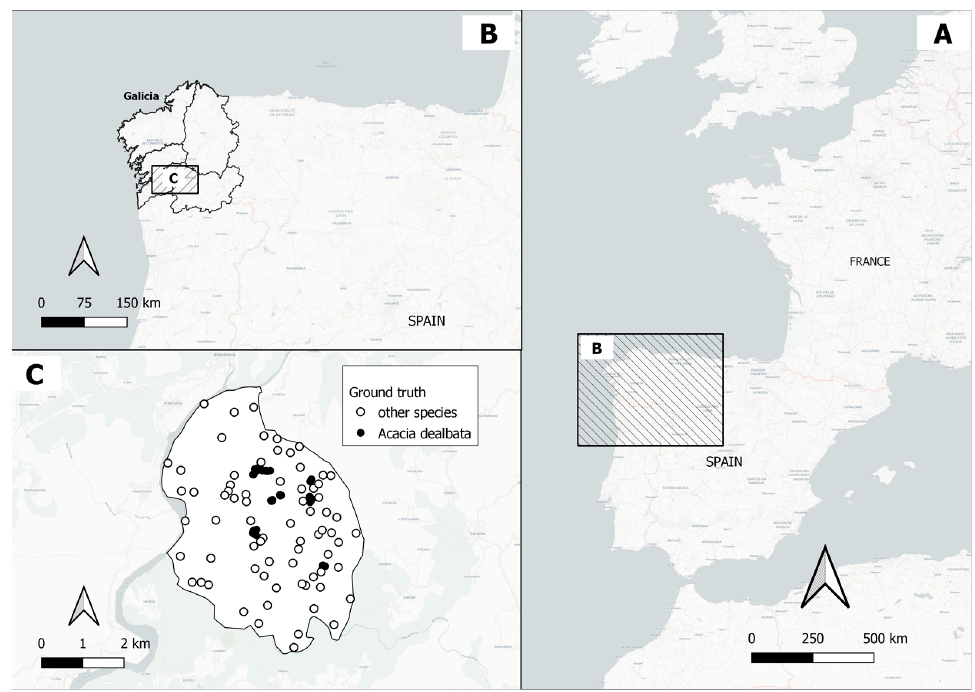
Figure 2. Localization of study area and field plots with presences and absences of Acacia dealbata . ( a ) Partial map of Europe where Spain is located, ( b ) partial map of Spain where Galicia is located, and ( c ) partial map of Galicia where Arnoia (study area) is located. The filled dots show the ground- truth points where A. dealbata has been detected, while the hole dots show the ground-truth data where other species have been detected.